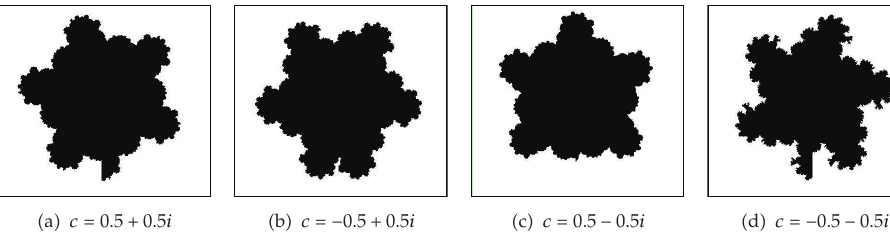
Figure 5: The generalized J sets without any perturbation when α (cid:6) 5 . 5, θ ∈ (cid:7) − π/ 2 , 3 π/ 2 (cid:4) .